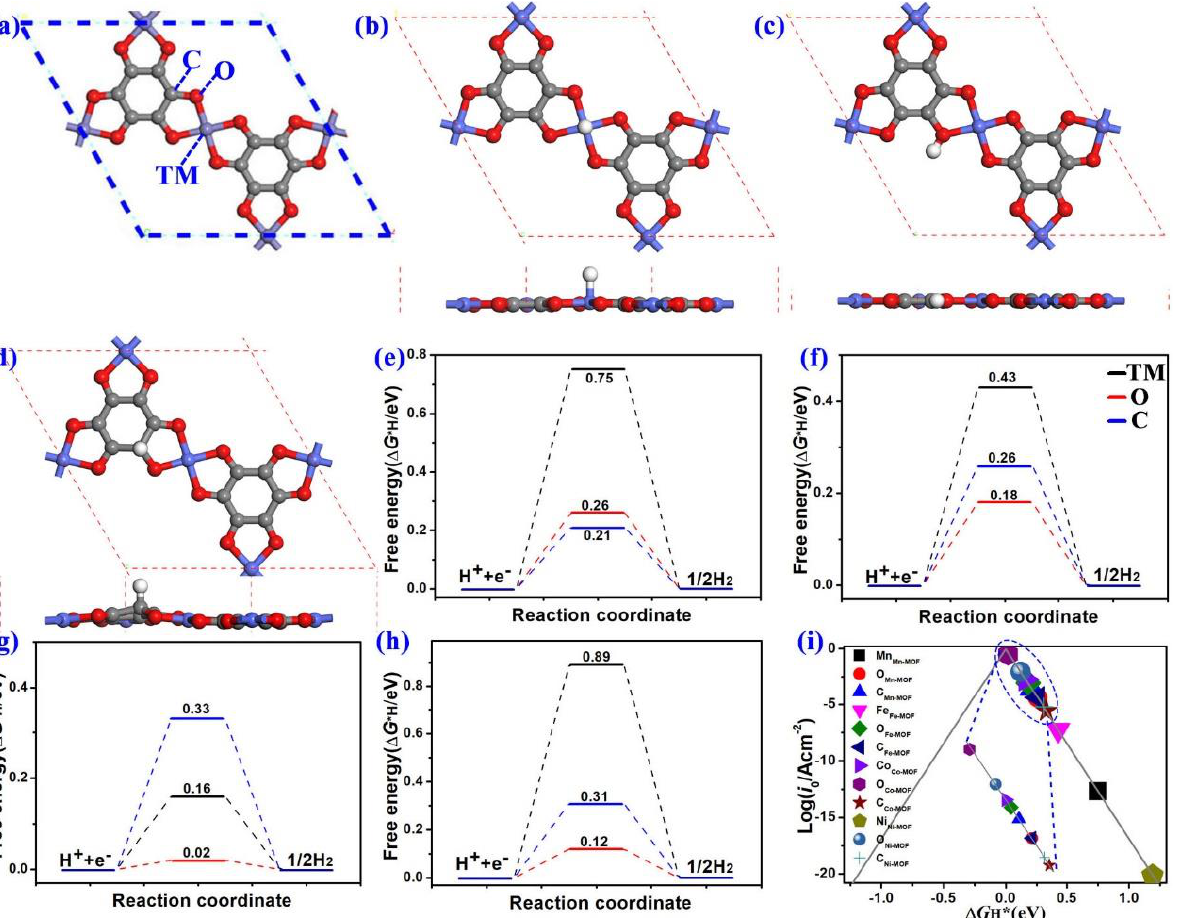
Figure 6. ( a ) The atomic structure of Co-O MOF. The optimized adsorption atomic structures of hydrogen on ( b ) TM, ( c ) O, and ( d ) C atoms. Gibbs free energy diagrams of hydrogen adsorption on ( e ) Mn-O MOF, ( f ) Fe-O MOF, ( g ) Co-O MOF, and ( h ) Ni-O-MOF. ( i ) Volcano curve of the density of exchange current ( i 0 ) vs. ∆ G H* on TM-O MOFs.